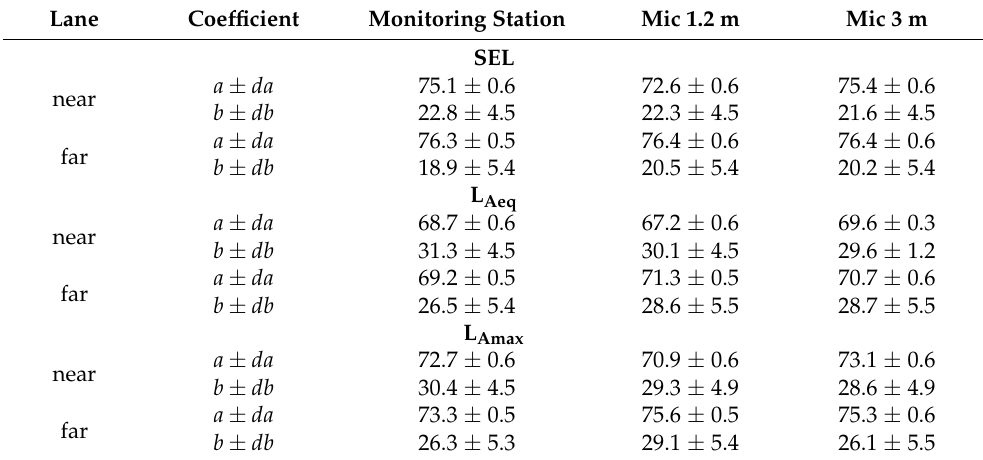
Table 4. Results with the morning common sample acquired in T1 for light vehicles. a and b units are